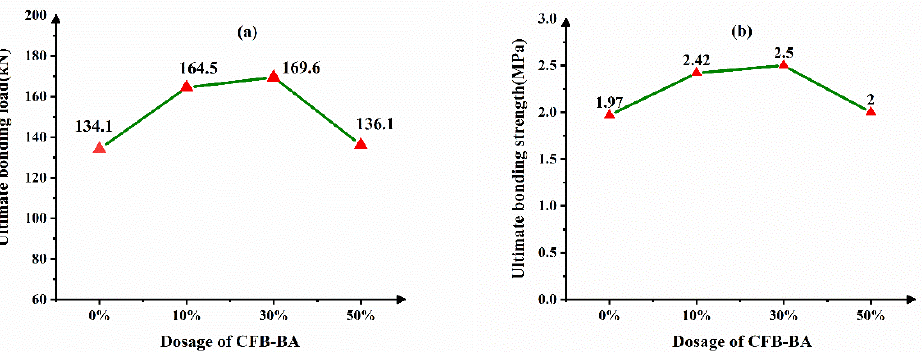
Figure 8. Dependence of CFB-BA dosage on the interface bonding behavior ( a ) ultimate bonding load ( b ) ultimate bonding strength.